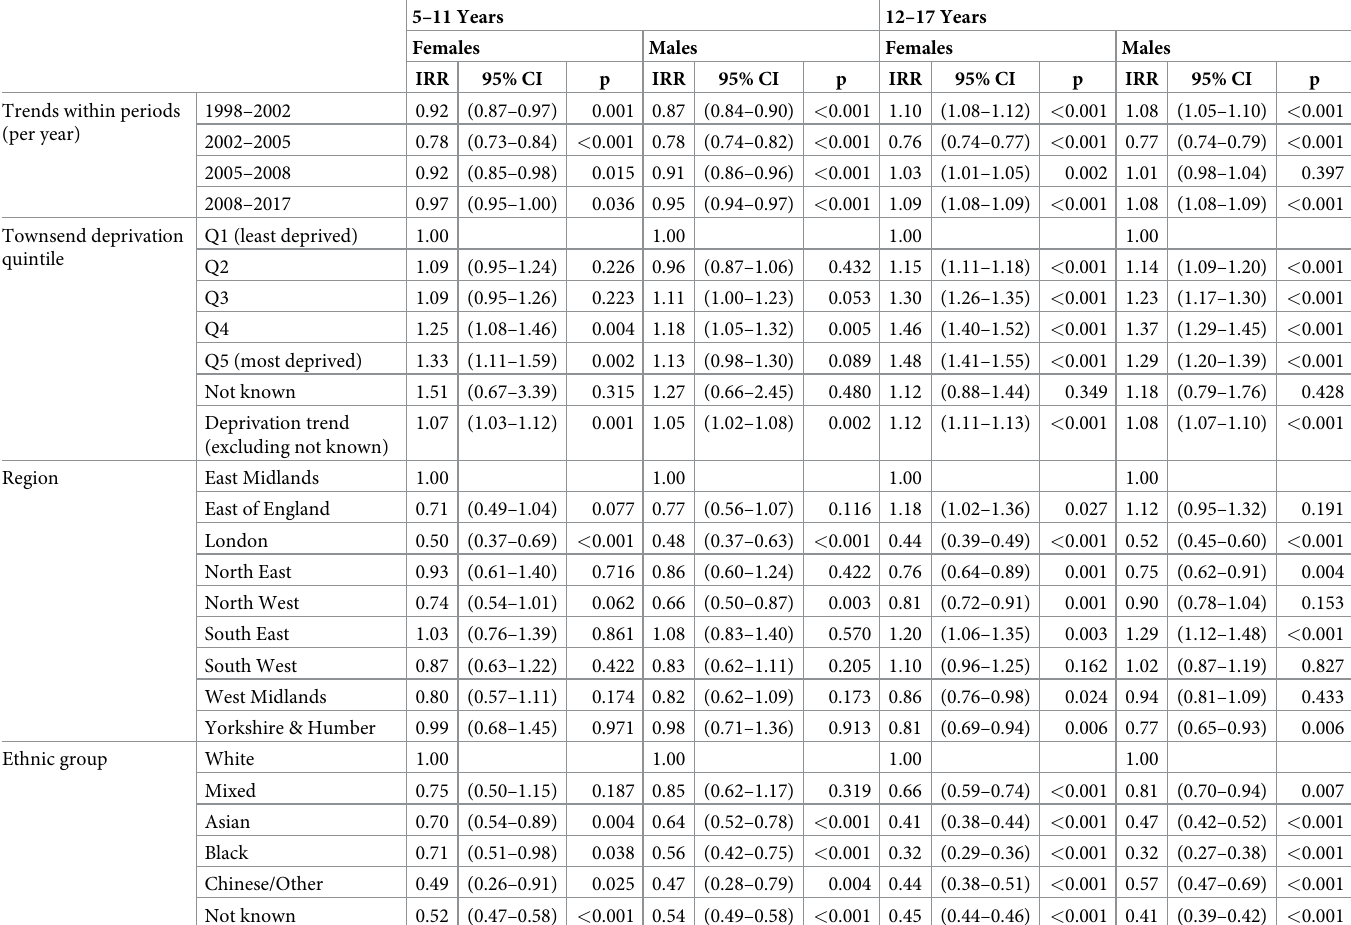
Table 3. IRRs for any antidepressant by age and sex fully adjusted for all variables shown and accounting for clustering by GP practice, England 1998–2017.